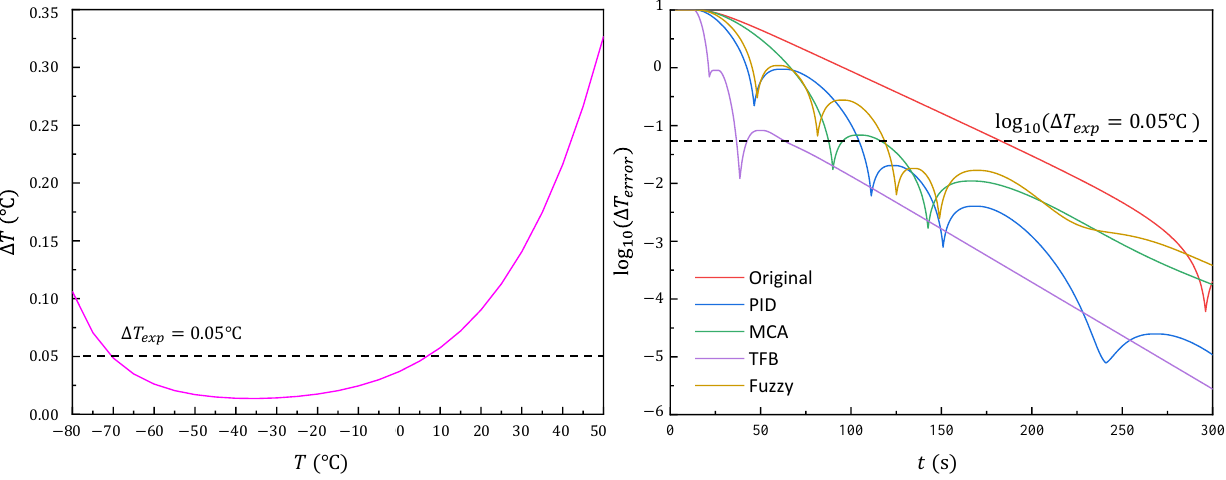
Figure 10. ( a ) Detection accuracy of the ADC circuit at different temperatures. ( b ) Stabilization time of starting calibration at different calibration temperature